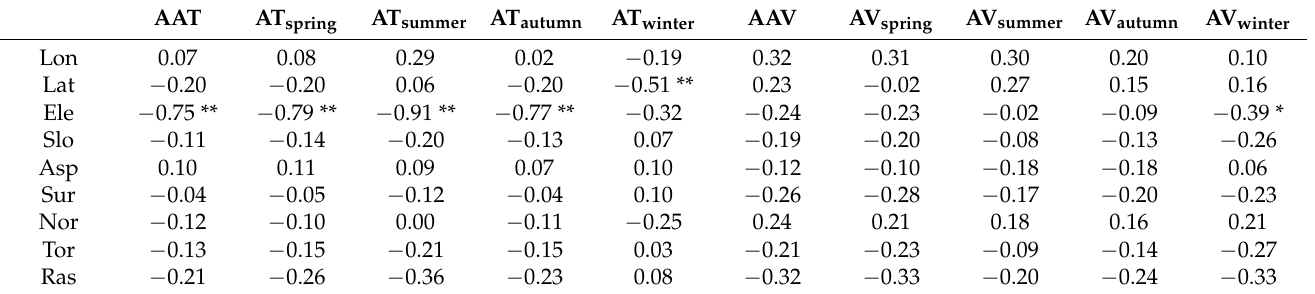
Table 2. The Pearson correlation between geographical and topographic variables and AAT, AT spring , AT summer , AT autumn , AT winter , AAV, AV spring , AV summer , AV autumn , and AV winter within the